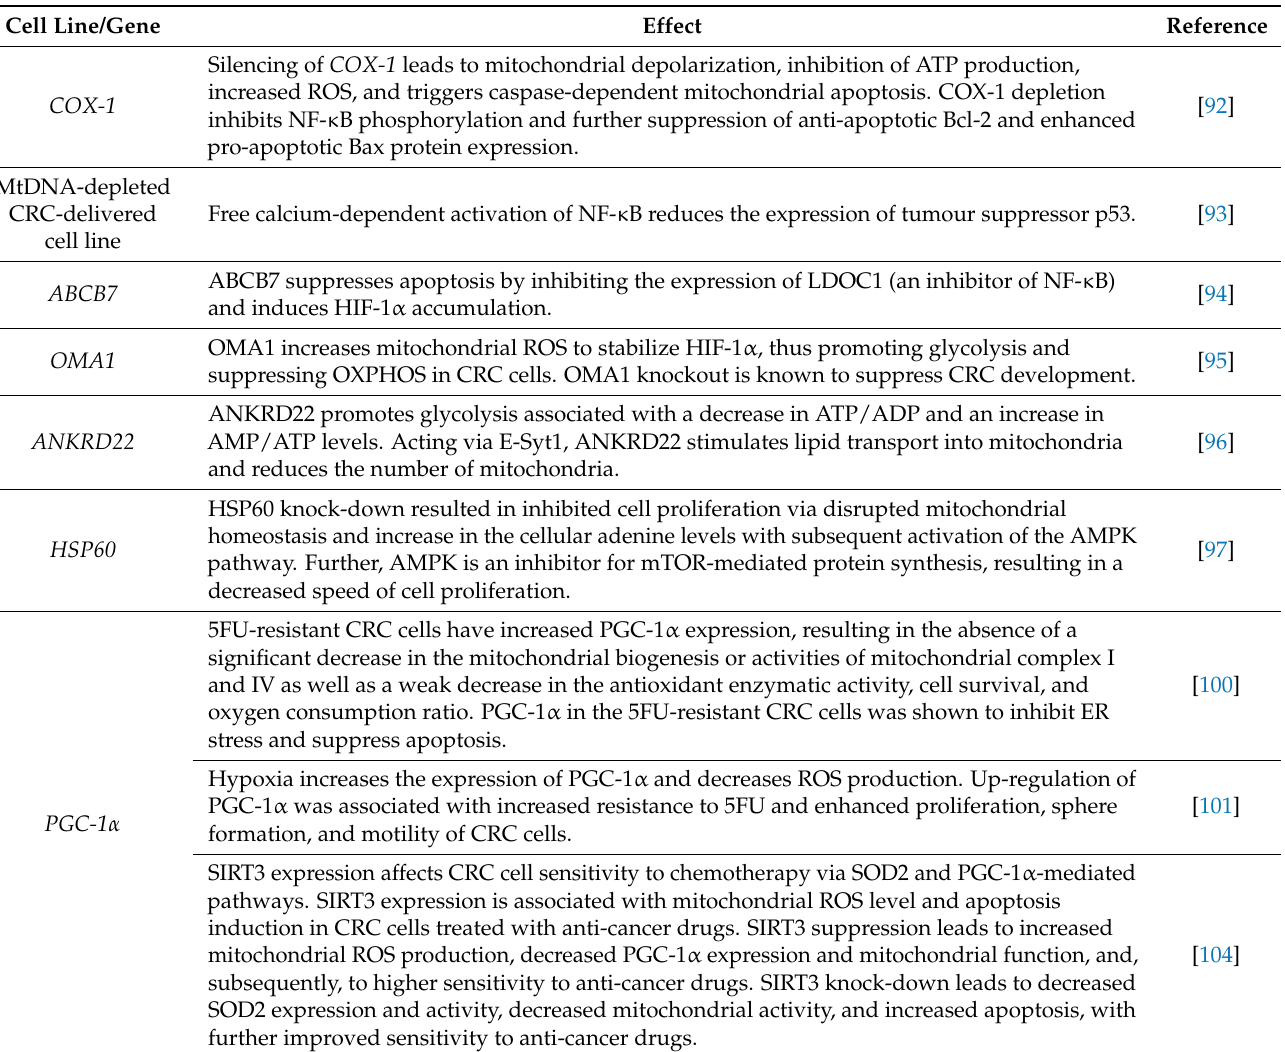
Table 1. The role of mitochondrial/mitochondria-localized proteins in IBD and CRC. Cell Line/Gene Effect